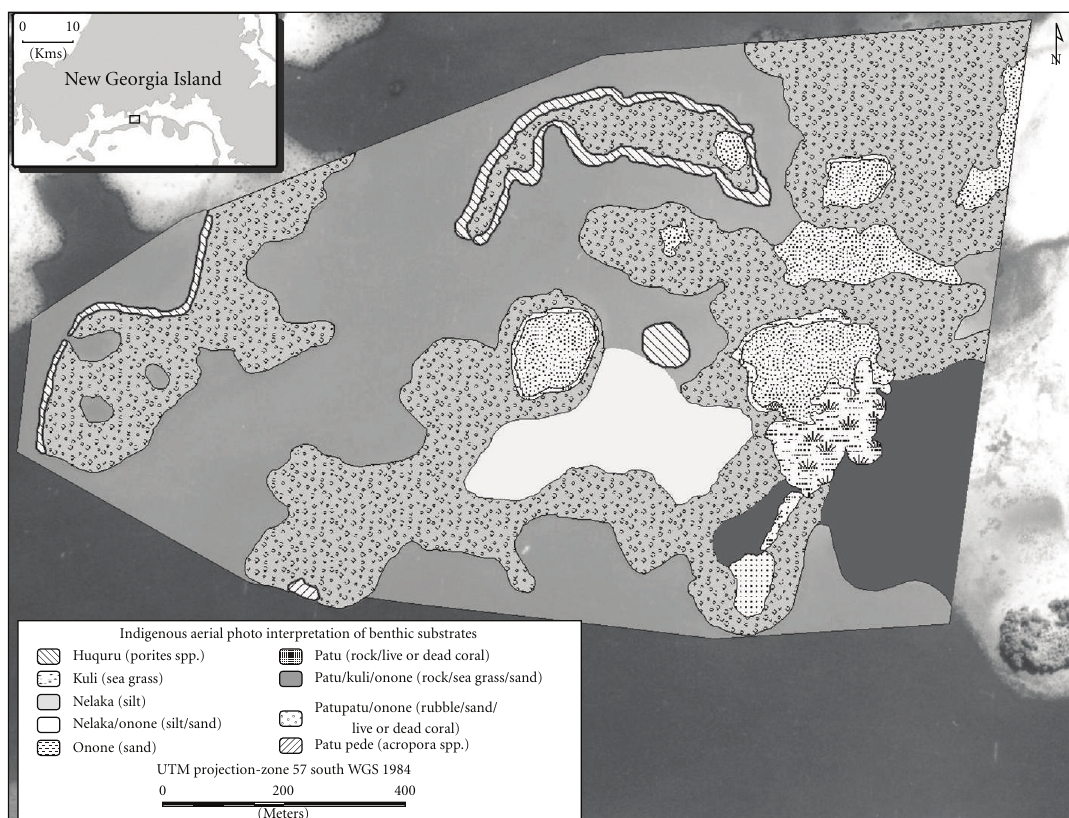
Figure 1: Informants’ demarcation of predominant abiotic and biotic substrates on the aerial photographs of the Baraulu MPA, Roviana Lagoon [45].